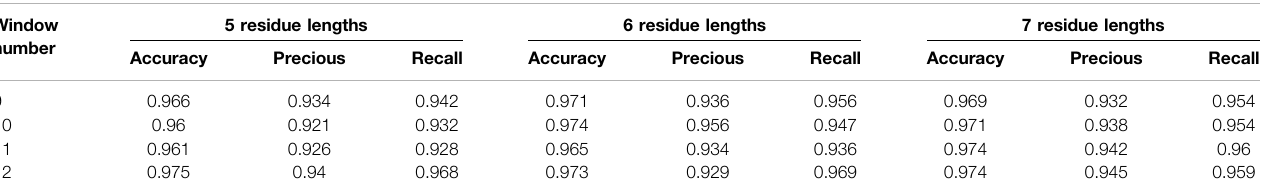
TABLE 1 | Accuracy performance of the model with different window size and window number. Window